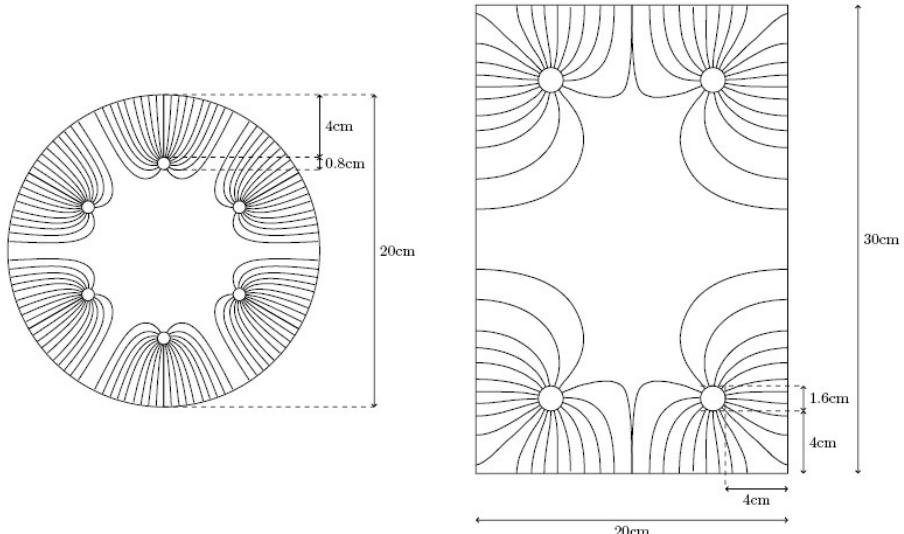
Figure 3. Different electric flow schemes during ECE application in an isotropic vertical element (circular section and regularly reinforced) and in an anisotropic vertical specimen (rectangular section and conventionally reinforced with rebar in the corners). Current streamlines, calculated using a standard finite element method, are